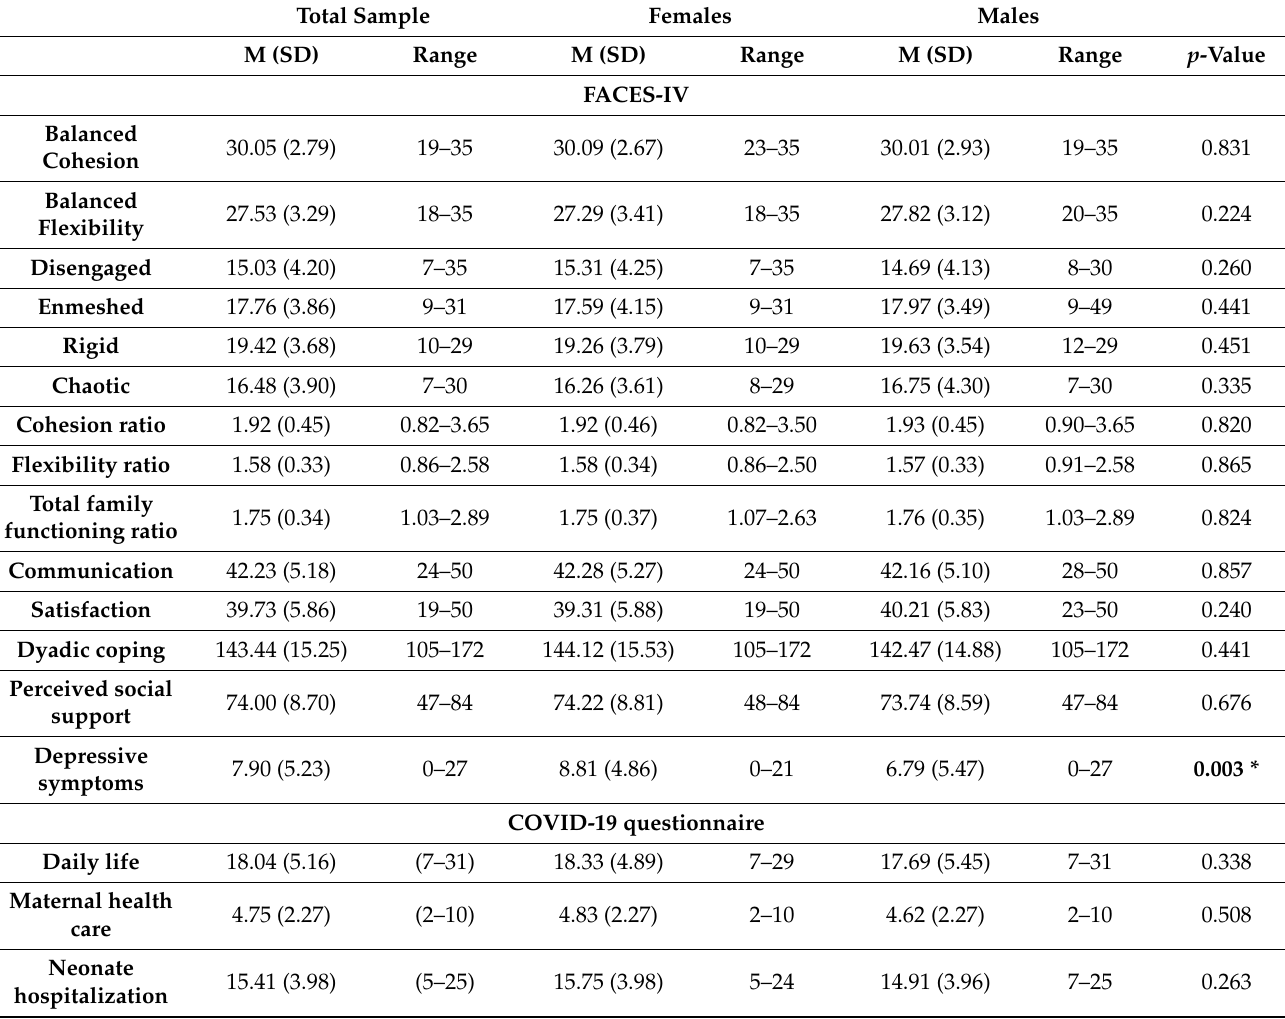
Table 2. Descriptive statistics for the whole sample and split by